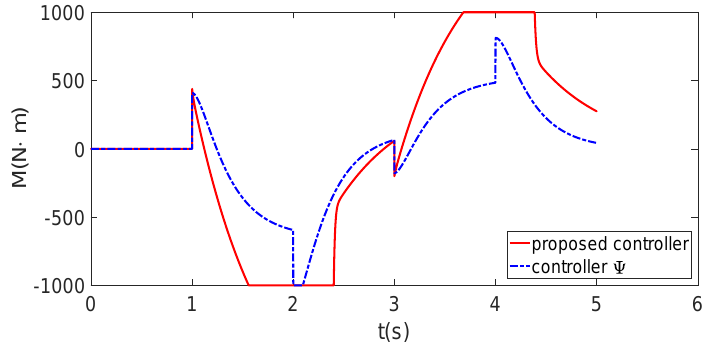
Figure 20. Yaw moment control input.